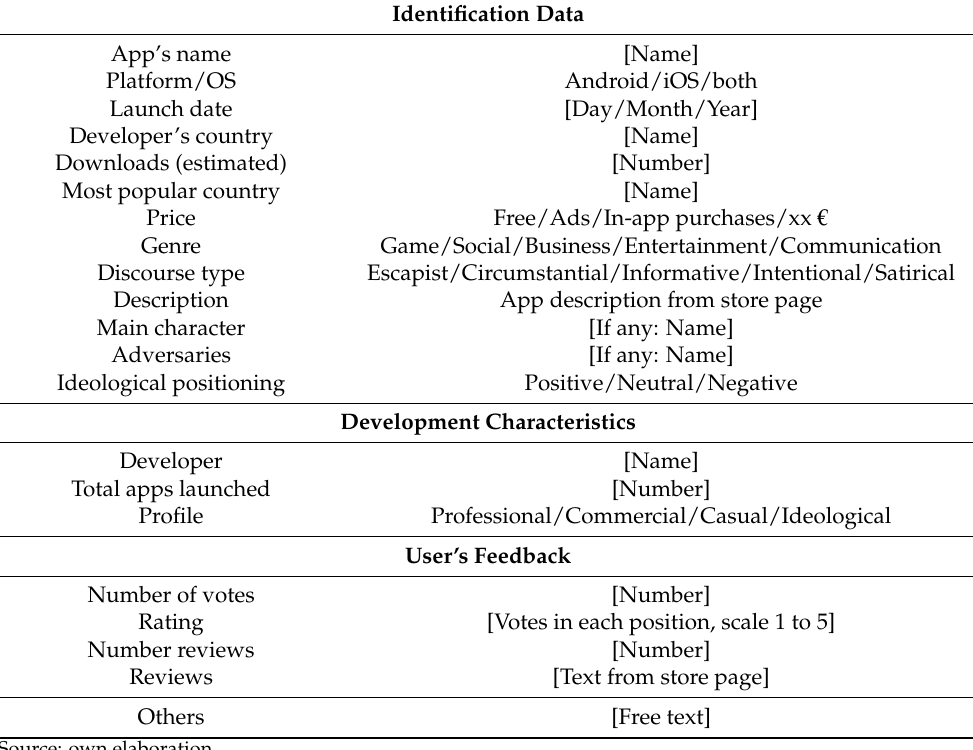
Table 2. Code sheet for app analysis.